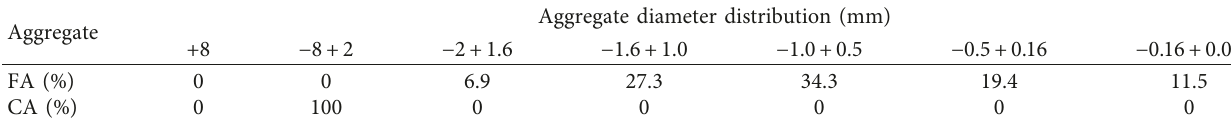
Table 3: Aggregate size distribution of the FA and CA.